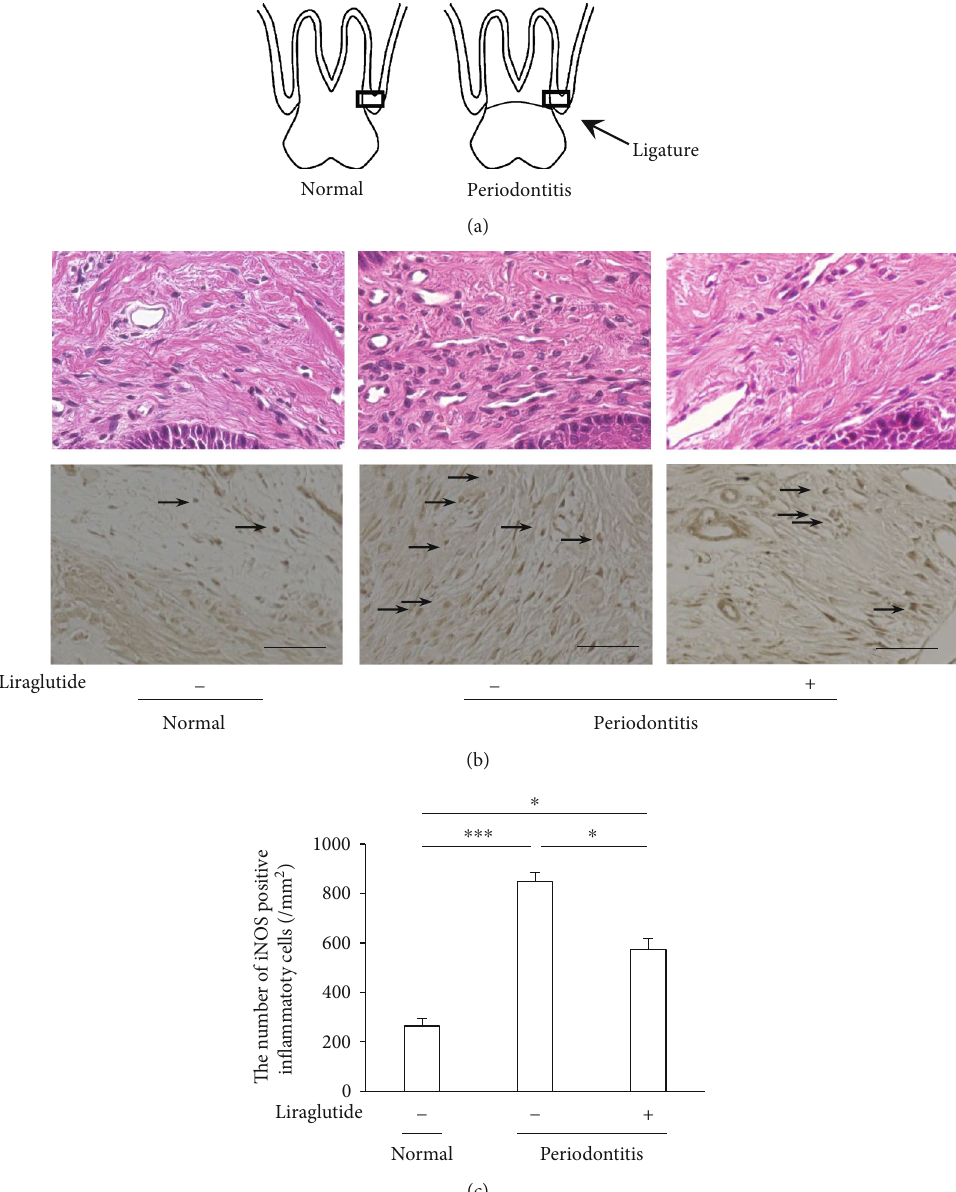
Figure 1: Histological evaluation of the gingiva. Liraglutide decreased the in fl ammatory cell invasion in periodontitis. (a) Schematic images of periodontal tissue with (periodontitis) and without (normal) ligation. The squares represent the parts shown in the below fi gures. (b) Upper panels: H&E staining of the periodontal tissues around the tooth 14 days after ligation. Lower panels: detection of iNOS-positive in fl ammatory cells in the gingiva. The black arrows mark iNOS-positive in fl ammatory cells. Scale bar = 5 0 μ m. (c) Quanti fi cation of iNOS- positive in fl ammatory cells in the gingiva. The results are expressed as the mean ± SEM ( n = 6 ). ∗ P < 0 : 05 and ∗∗∗ P < 0 : 001